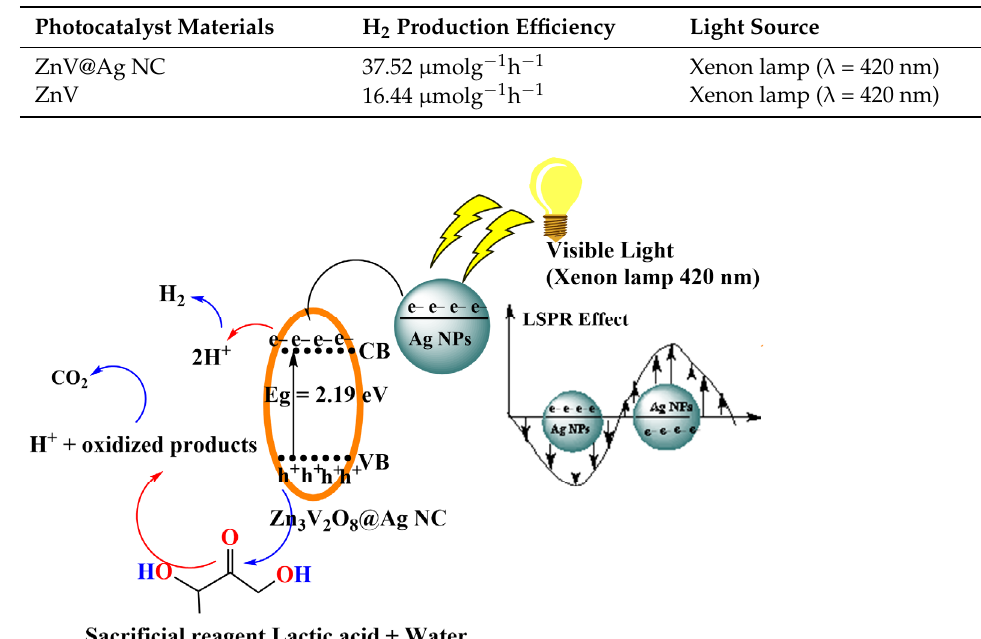
Table 2. H 2 production activities of ZnV and ZnV@Ag